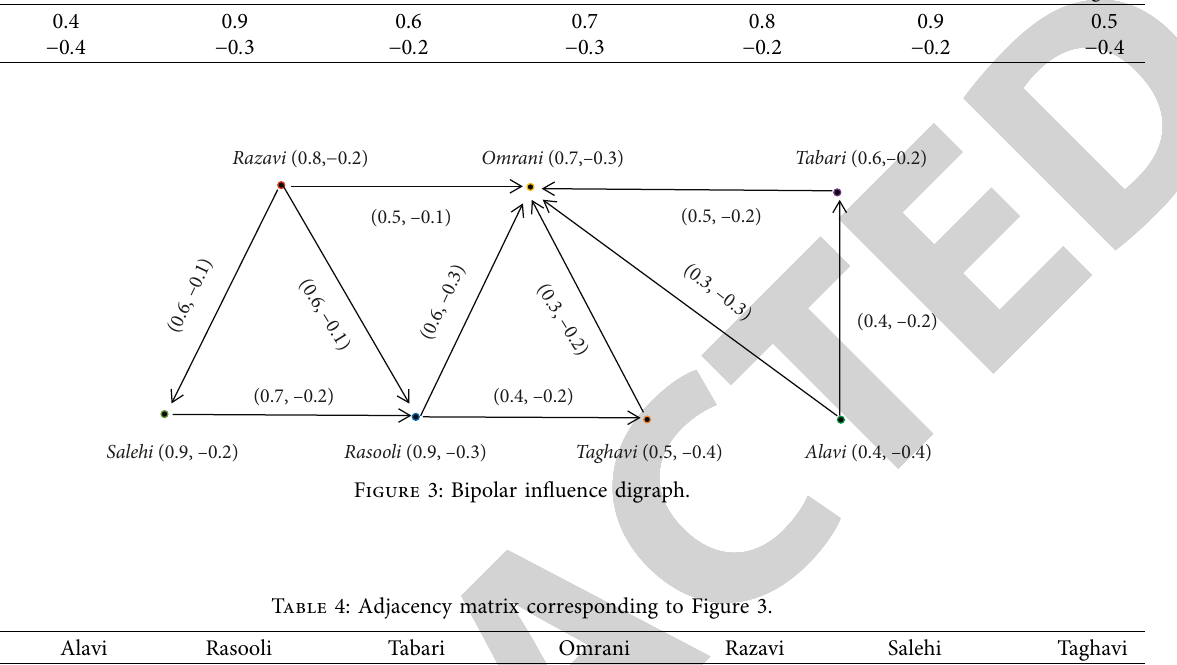
Figure 3: Bipolar influence digraph.